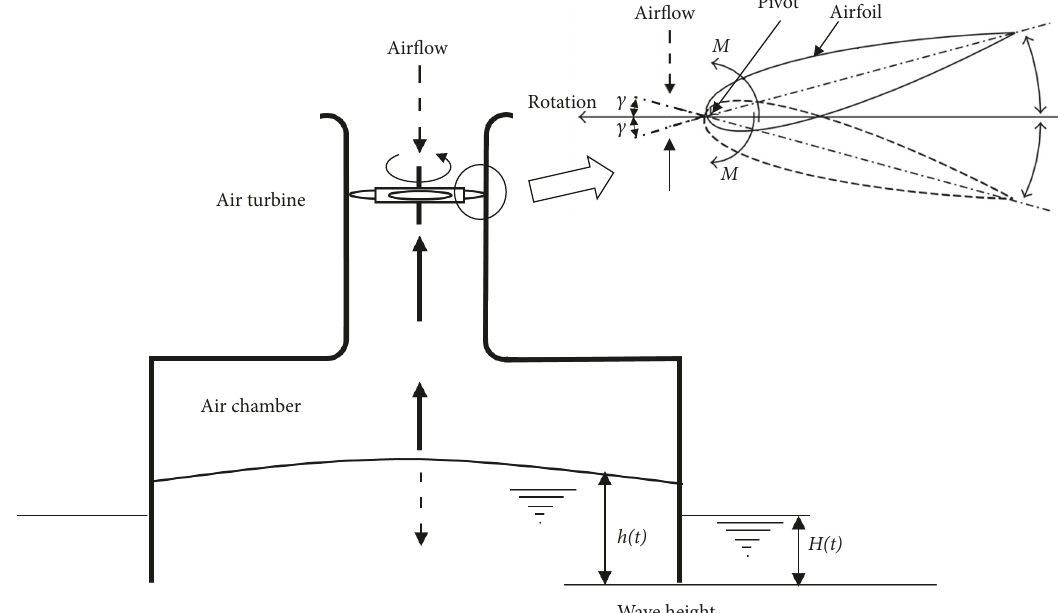
Figure 4: Wells turbine with pitch control.